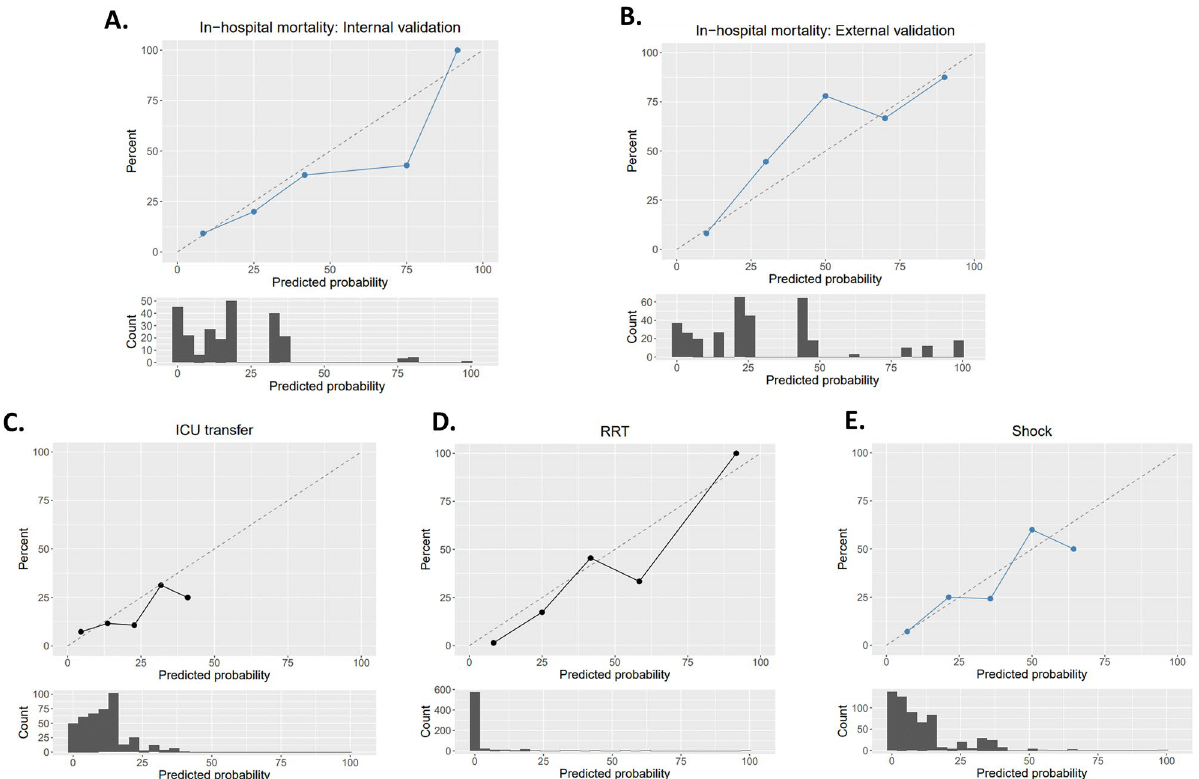
Figure 4. Calibration plots for prediction models. ( A ) 28-days mortality in the internal validation. ( B ) 28-days mortality in the external validation. ( C ) 28-day ICU transfer in the internal validation. ( D ) 28-day receipt of RRT in the internal validation. ( E ) 28-day shock in the internal